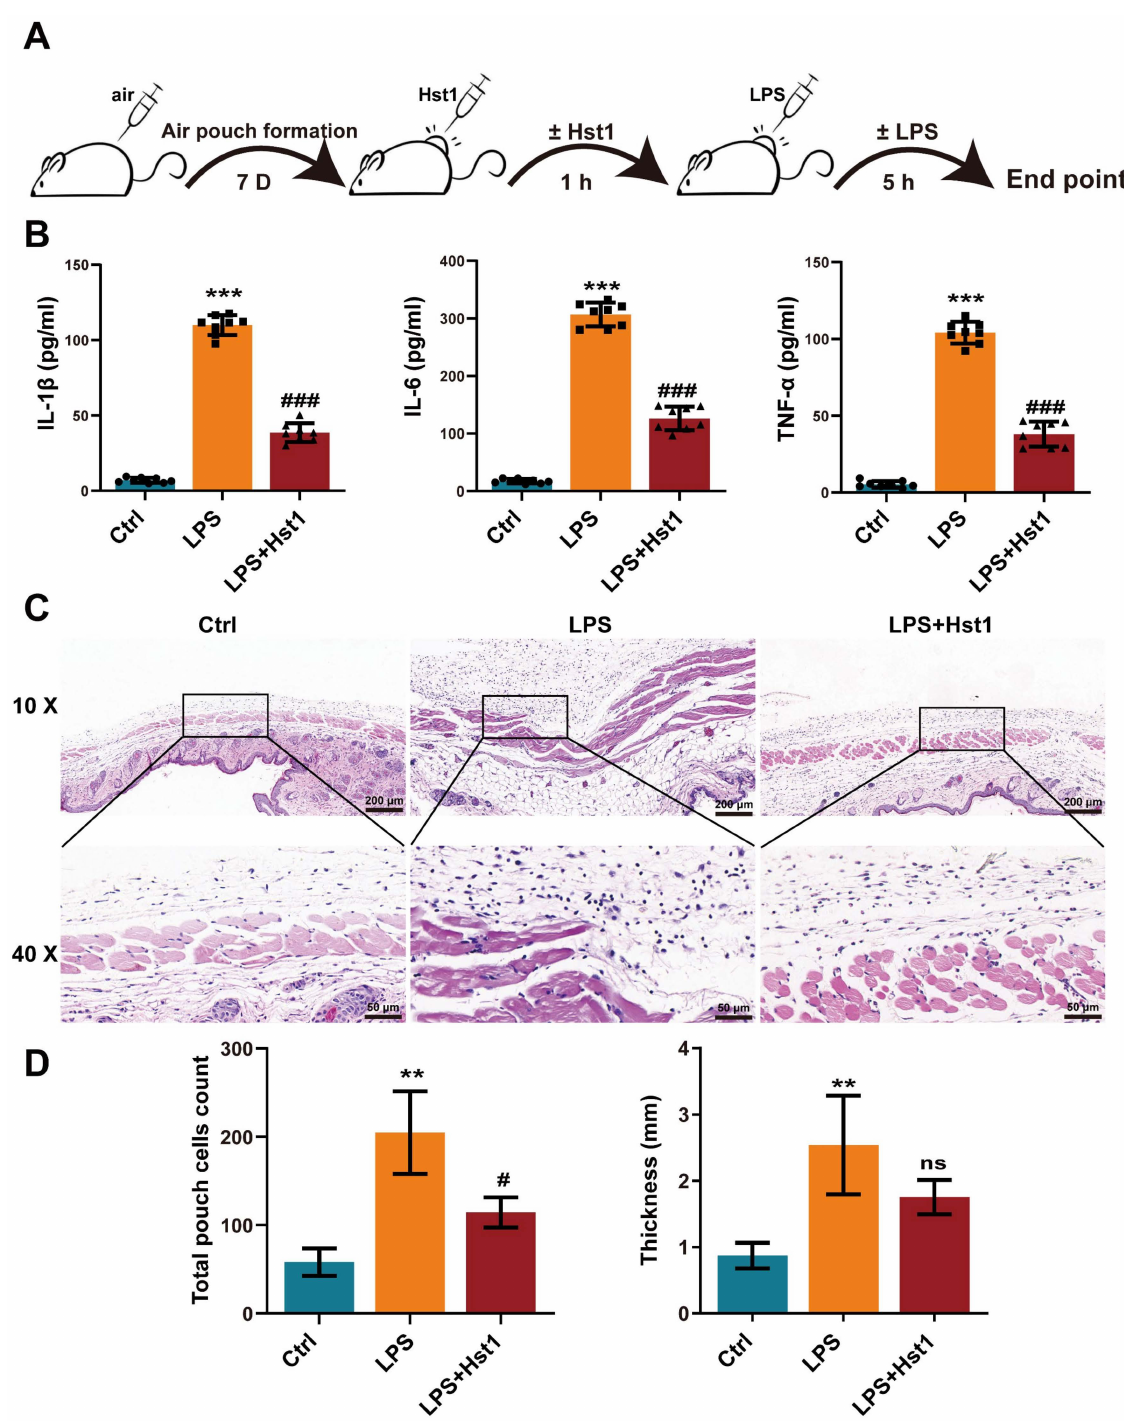
Figure 3. Hst1 suppressed inflammation in acute air pouch model in mice. ( A ) The procedure of creating the mice air pouch model and administering Hst1 treatment. ( B ) The production levels of IL-6, IL-1 β , and TNF- α in the air pouch lavage fluid were determined by using ELISA, n = 8. ( C ) H&E staining of air pouch subcutaneous tissue sections, n = 3; scale bar = 200 µ m in top row and 50 µ m in bottom row. ( D ) Quantification of infiltrated cells and thickness of subcutaneous tissue, n = 3. Data are expressed as means ± SD from ≥ three independent experiments. Significant differences compared to control group: ** p <0.01 and *** p < 0.001, and compared to LPS group: # p <0.05 and ### p < 0.001; ns: not